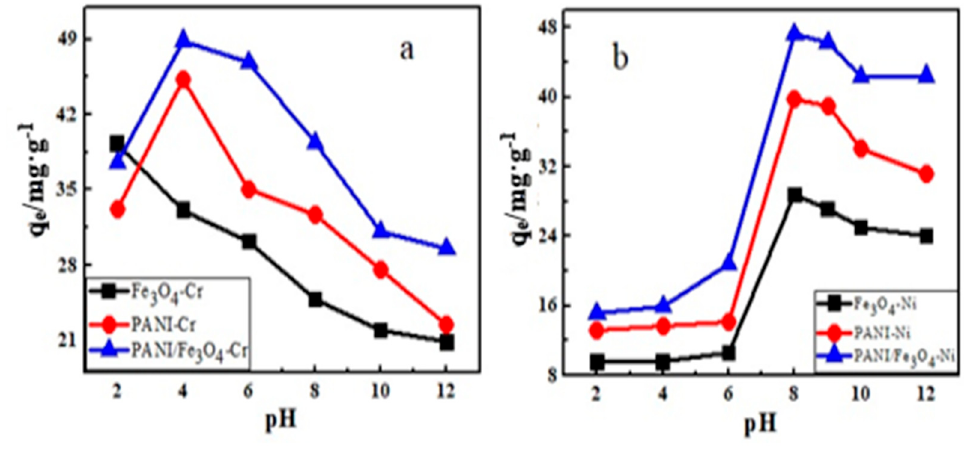
Figure6. pHe ff ectonremovalof( a )Cr(VI),( b )Ni(II)throughFe 3 O 4 , PANI,andPANI / Fe 3 O 4 Figure 6. pH effect on removal of ( a ) Cr(VI), ( b ) Ni(II) through Fe 3 O 4 , PANI, and PANI/Fe 3 O 4 composites.